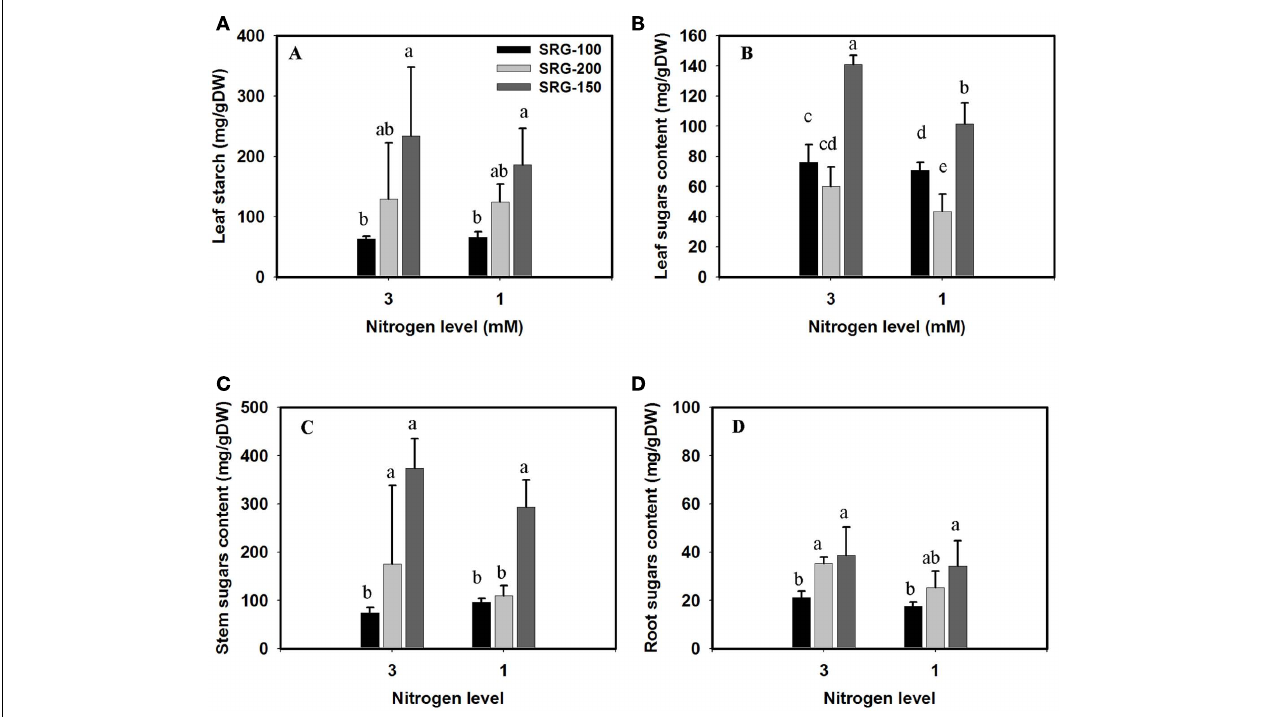
FIGURE 6 | Starch and total sugar content in the three genotypes; SRG-100 (black bars); SRG-200 (light gray bars); and SRG-150 (Dark gray Bars) under optimal (3mM) and limiting N (1mM) condition. Starch content in the leaves (A) ; sugar content in the leaves, stems, and roots (B–D) . Data are means ± SD ( n = 3 each replicate represent four plants). Bars with different letters indicate a significant difference at P ≤ 0.05 (Tukey’s Honestly Significant DifferenceTest).